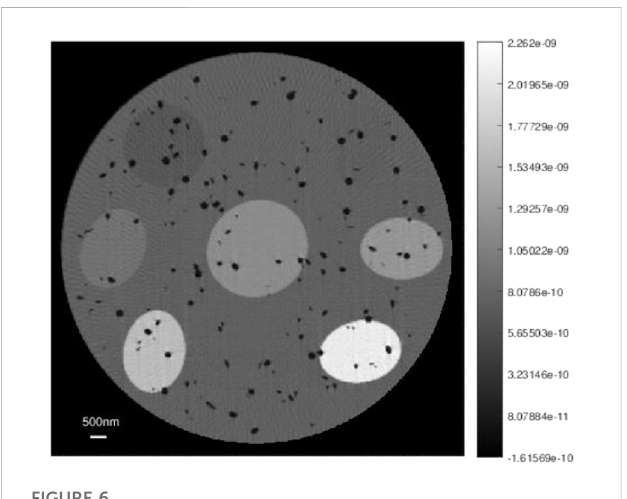
FIGURE 6 The inversion result using LSM for noiseless data.